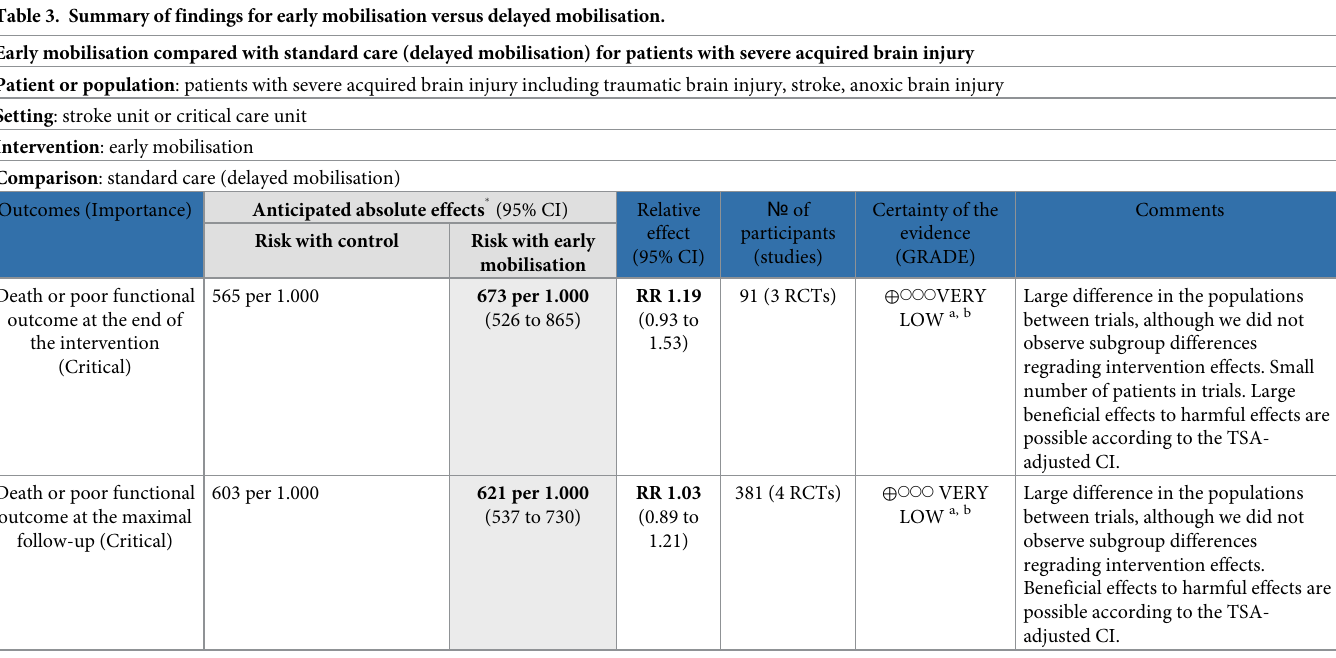
Table 3. Summary of findings for early mobilisation versus delayed